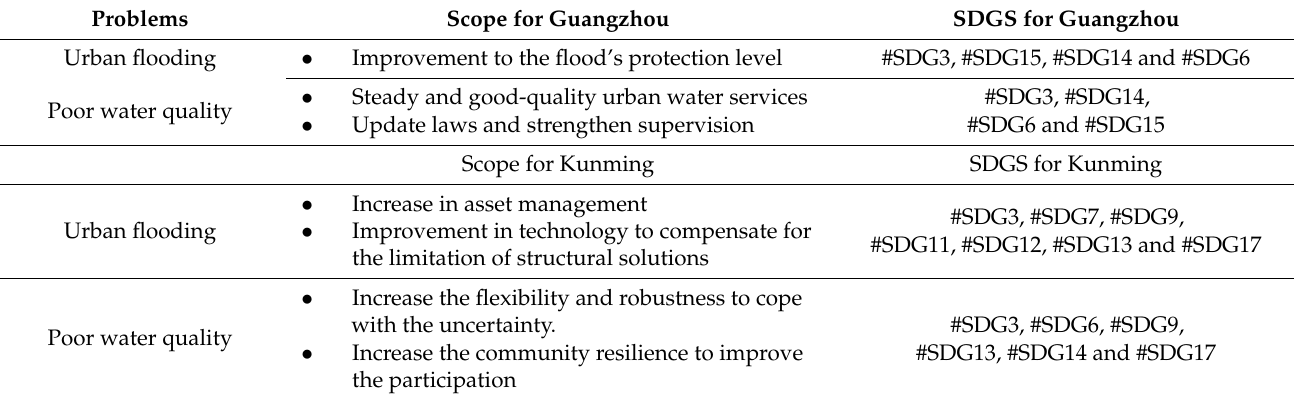
Table 5. The response of urban water development to SDGs in Guangzhou and Kunming. Problems Scope for Guangzhou SDGS for Guangzhou Urban